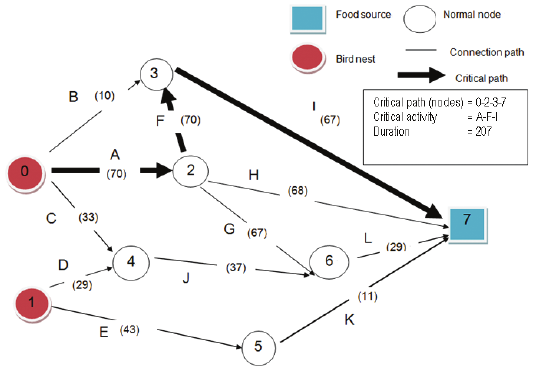
Fig. 4. Network topology result in Step 1 using CSAM-ACO acceleration model